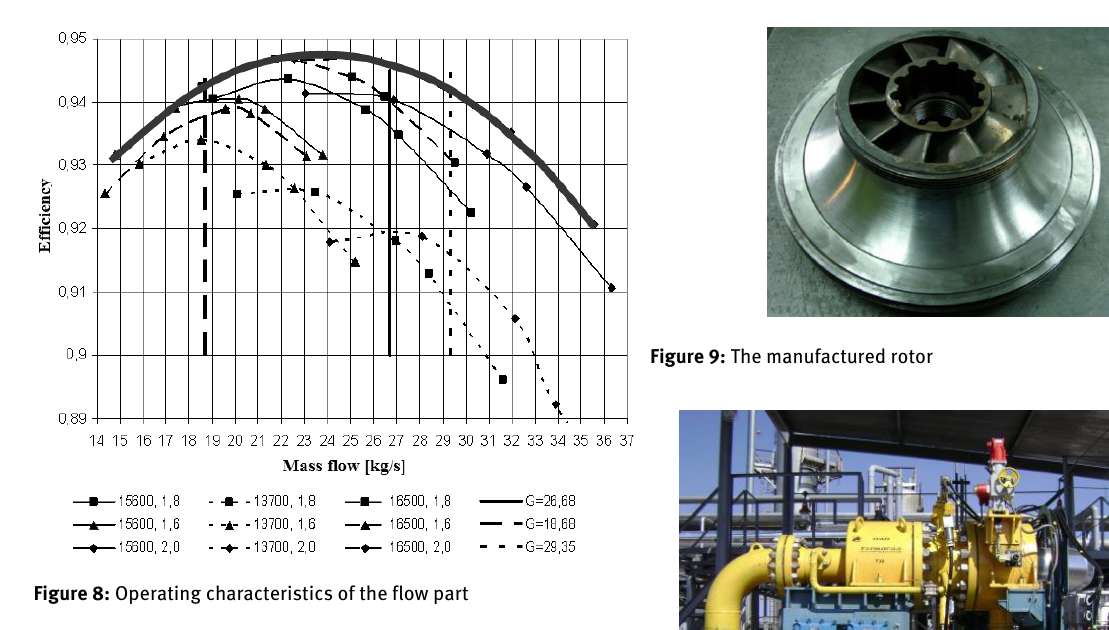
Figure 8. Operating characteristics of the flow part